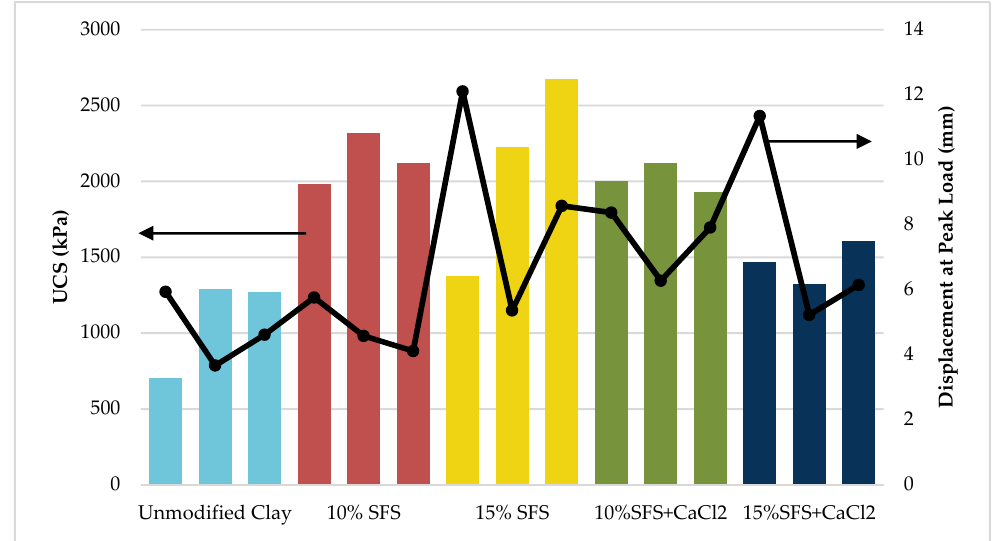
Figure 4. Unconfined compressive strength (UCS) comparison of clay samples.